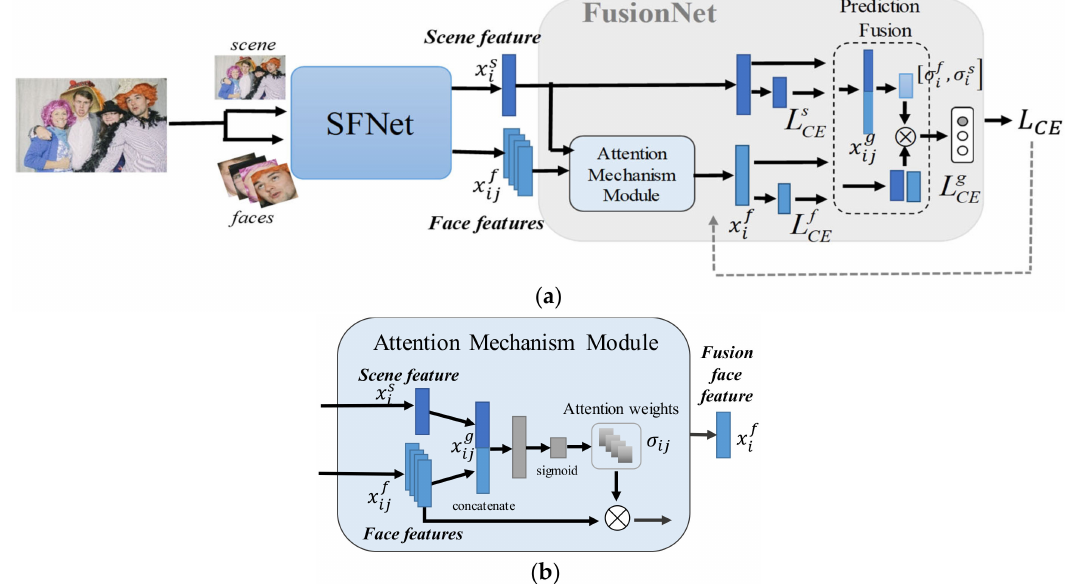
Figure 2. The structure and training flow of FusionNet. ( a ) The training flow of SFNet and FusionNet; ( b ) attention mechanism module in